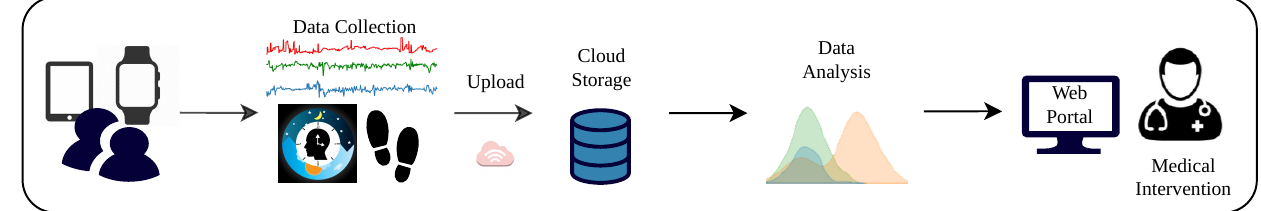
Figure 1. The e-Prevention system’s